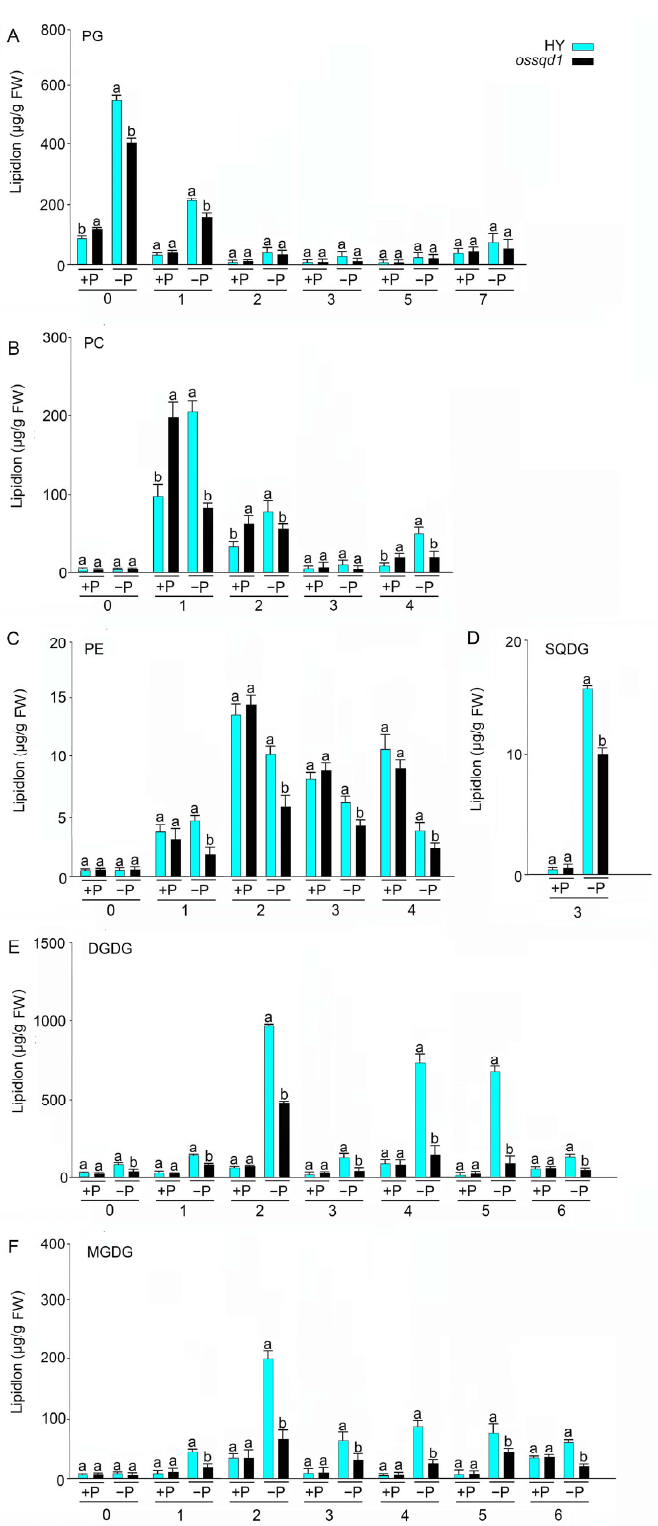
Figure 4. Knockout of OsSQD1 affects the fatty acid saturation of different lipid species under different Pi regimes. The lipid saturation of PG ( A ), PC ( B ), PE ( C ), SQDG ( D ), DGDG ( E ) and MGDG ( F ). The abscissa represents the number of unsaturated bonds. Values are means ± SE ( n = 4). Different letters indicate that the values differ significantly between WT and ossqd1 mutant ( p < 0.05, one-way analysis of variance, Duncan’s